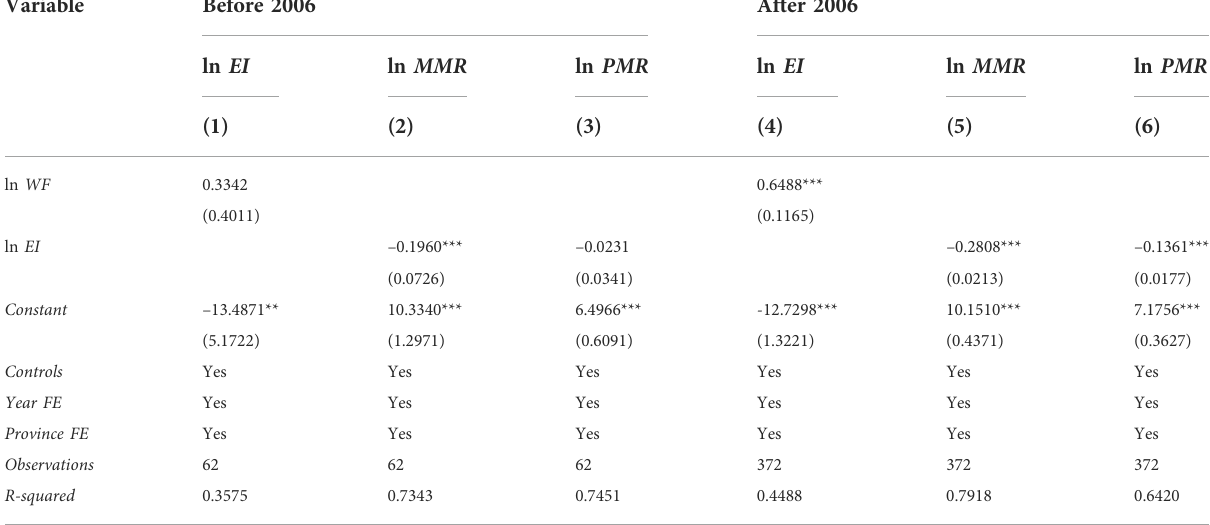
TABLE 8 Results for the effect of the 2006 cadre evaluation system reform.